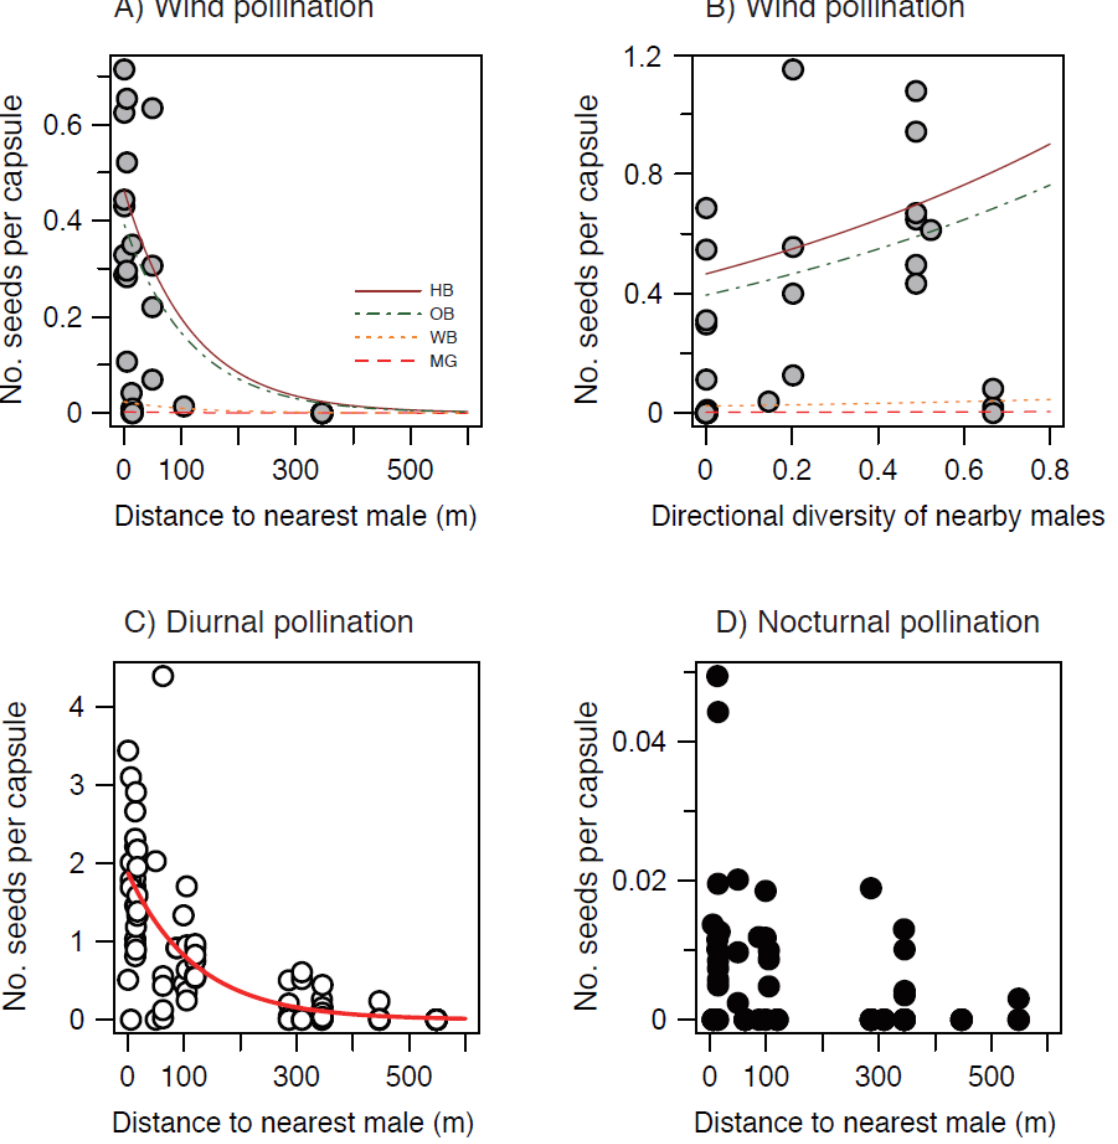
Figure 3. Effects of local mate availability on seed set of Salix caprea in different pollination treatments, showing the relationships between the number of seeds per capsule and the distance to the nearest male (A: wind, C: diurnal, D: nocturnal) or the directional diversity of nearby male (B: wind). The regression curves are drawn based on the estimated fixed effects in those GLMMs (A: P <0.001; B: P <0.0001; C: P <0.001; D: P = 0.14, type II Wald chi-square tests). The number of seeds was adjusted for the estimated random effect (plant) prior to data plotting. For wind pollination treatment, the number of seeds was further adjusted for the variance explained by (A) the directional diversity of nearby males or (B) the distance to the nearest male, and the regression curves were drawn separately for four populations by using the estimated random effect